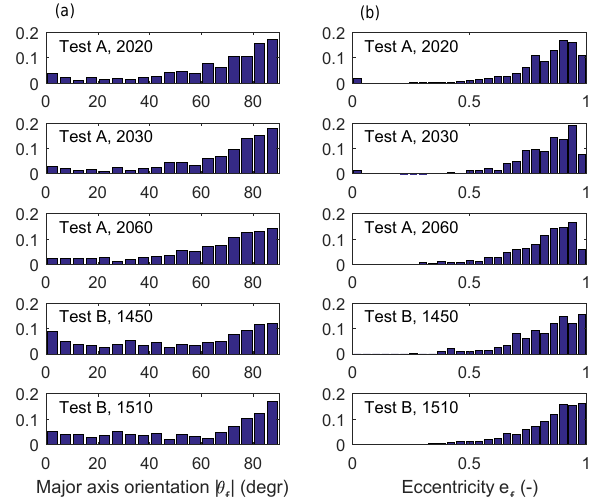
Figure 3. Histograms of the absolute value of floe orientation | θ f | (a) and eccentricity e f (b) in the five analyzed tests, for floes with s > 5 × 10 − 3 m 2 . Bin widths equal 5 ◦ and 0.04, respectively; bar heights are normalized so that their total area in each panel equals